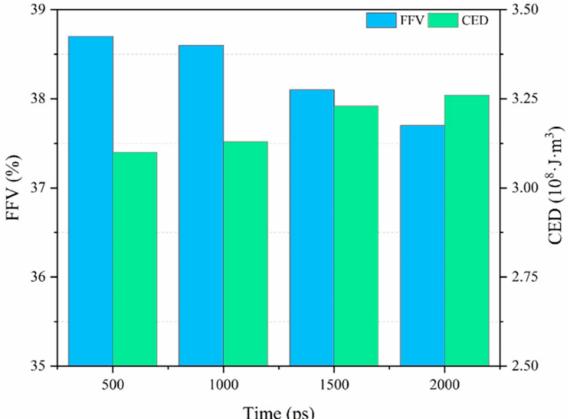
Figure 9. FFV and CED under different diffusion